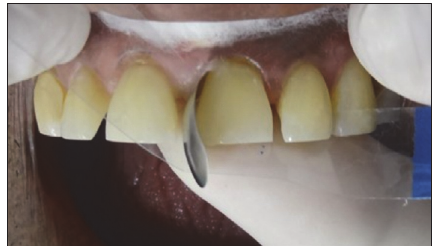
Figure 7: Anatomic contours can be easily achieved using the contoured matrix.